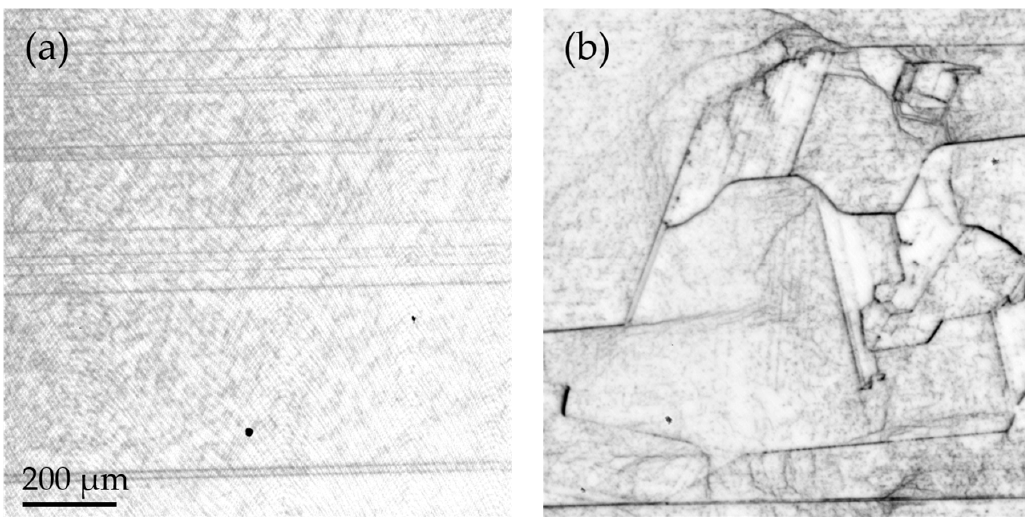
Figure 2. Electron-beam-induced current (EBIC) images of dendrite region ( a ) and non-dendrite grains ( b ).